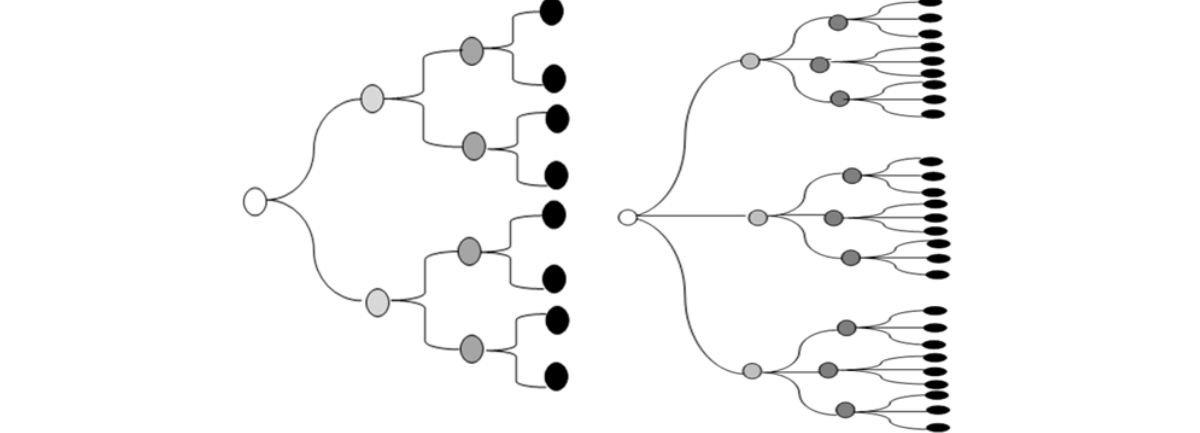
Figure 1. Increase in the number of cases over subsequent generations of the infection for (a) a reproductive number of 2 and (b) a reproductive number of